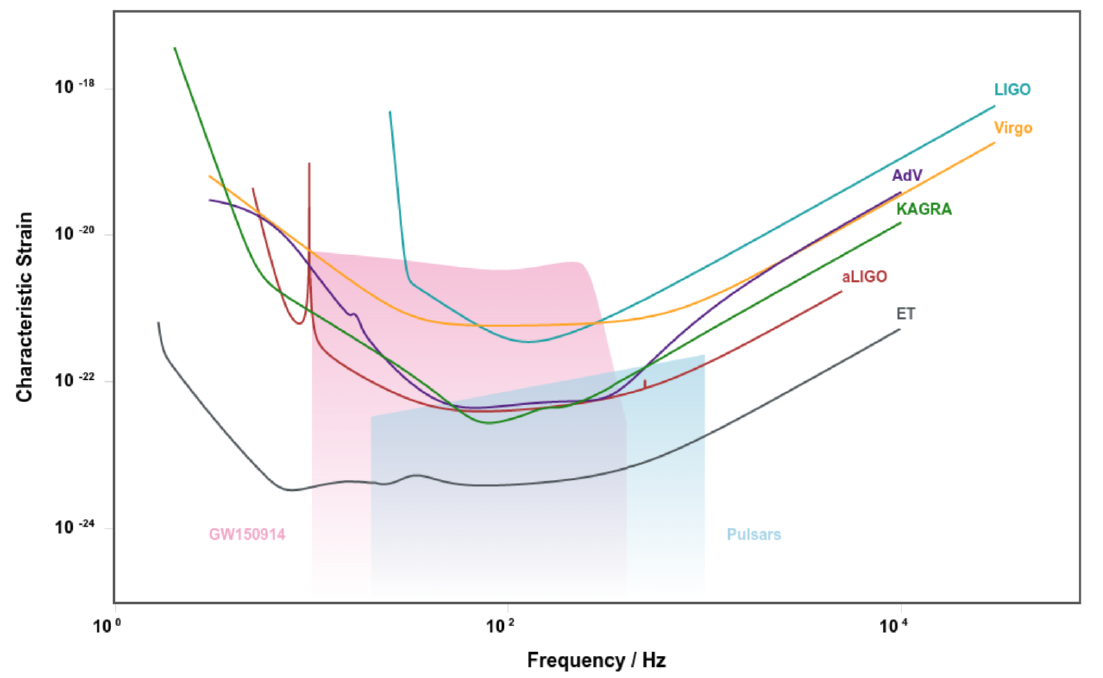
Figure 1. Comparison of the characteristic strains as a function of GW frequency for existing and planned ground-based detectors (for details see [45]; plot generated with an interactive tool at http://gwplotter.com). The expected CGWs amplitudes ranges of pulsars are marked with the pastel-blue region. For comparison, the GW150914 signal strain is represented by the pink